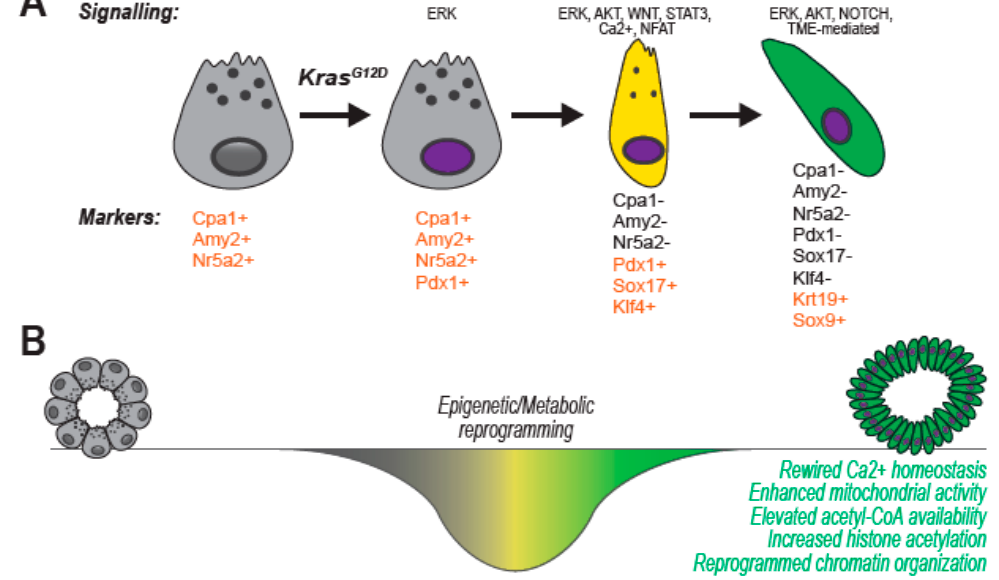
Figure 4. Cellular reprogramming during acinar-to-ductal metaplasia (ADM). In ( A ) ex vivo-isolated acinar cells transition to a tumor-initiating ductal phenotype. Cell identity is impacted: undergoing ADM, the cell loses its secretory function (apical granules disappear), changes morphology (acquire a more elongated, brick-like structure). Gene expression and markers are dynamically regulated, as shown in the lower panel. Transition in cell identity is a continuum, which progresses through de-differentiation into a progenitor-like cell type (in yellow) and culminates in a duct-like cell (in green). ( B ) Acinar-to-Ductal Metaplasia is critically supported by both epigenetic and metabolic reprogramming. Mechanisms for active cellular remodeling are necessary to switch cell identity across two terminally-differentiated states.